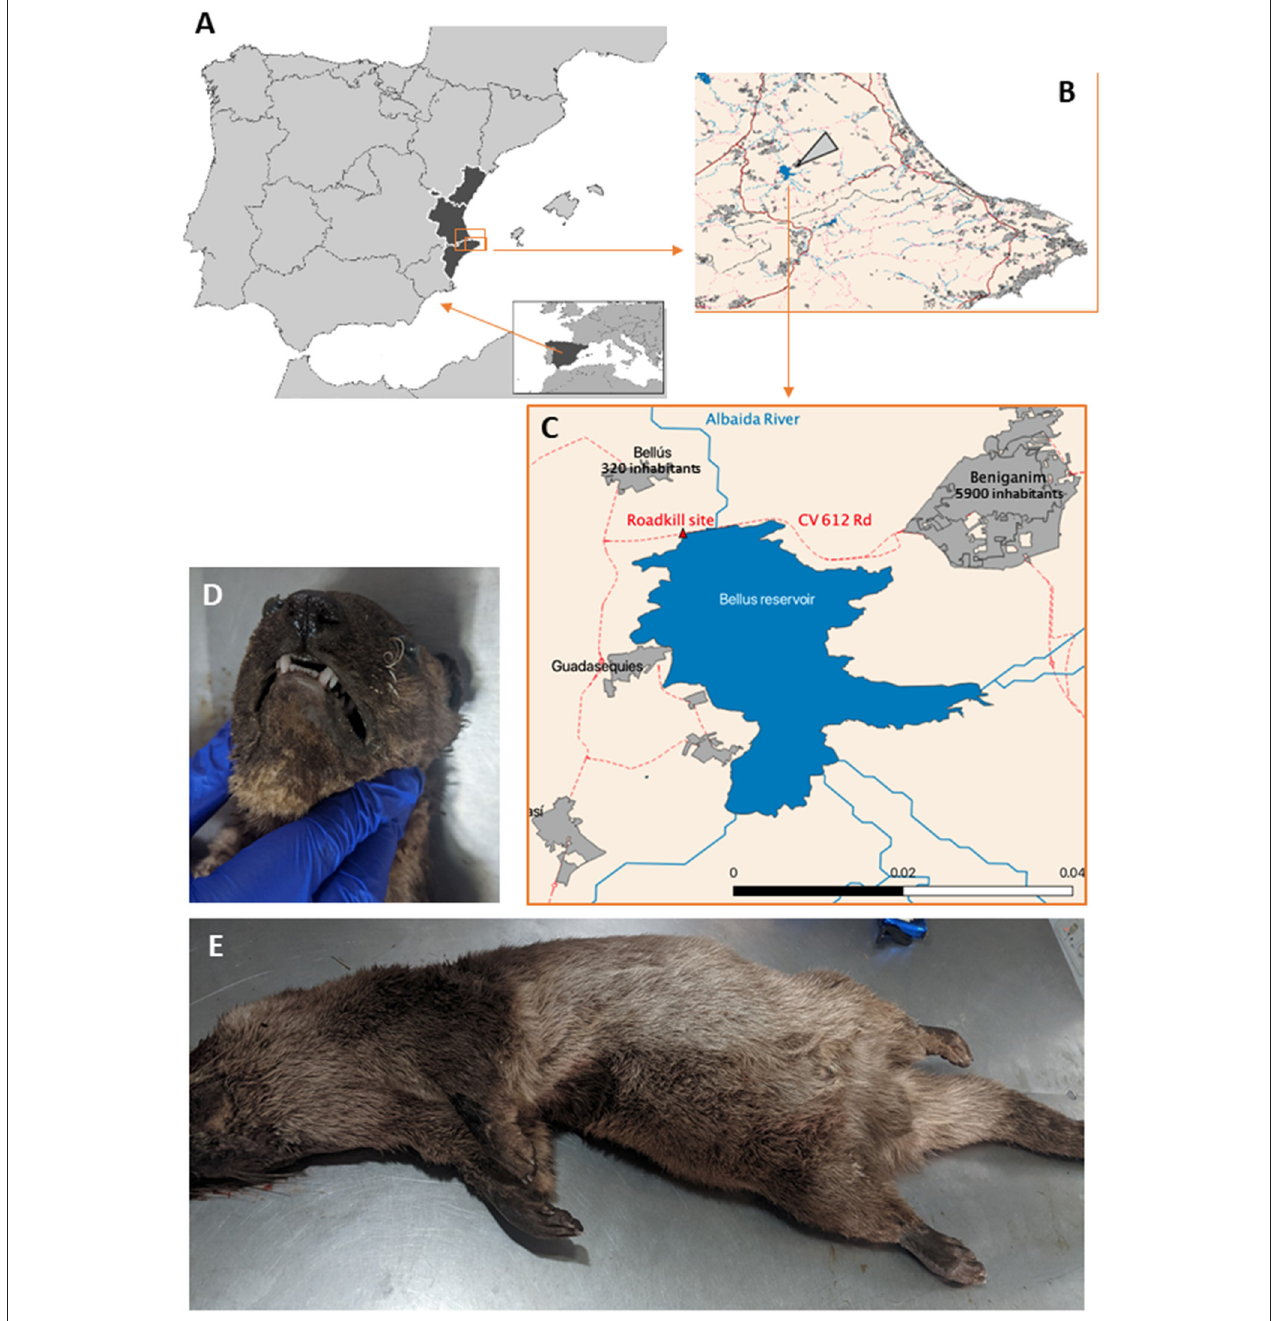
FIGURE 1 | Otter carcass retrieval site and external aspect of the animal. (A) Europe (inset) and (main figure) Iberian Peninsula (Spain and Portugal) with the Valencian region in black, enclosing in a rectangle the area that is enlarged in (B) , where the large arrowhead points to the Bellús reservoir, (C) zooming on it and its surrounding area, marking the site where the animal was found. (D,E) Shows, respectively, views of the head and the remainder of the body of the animal.